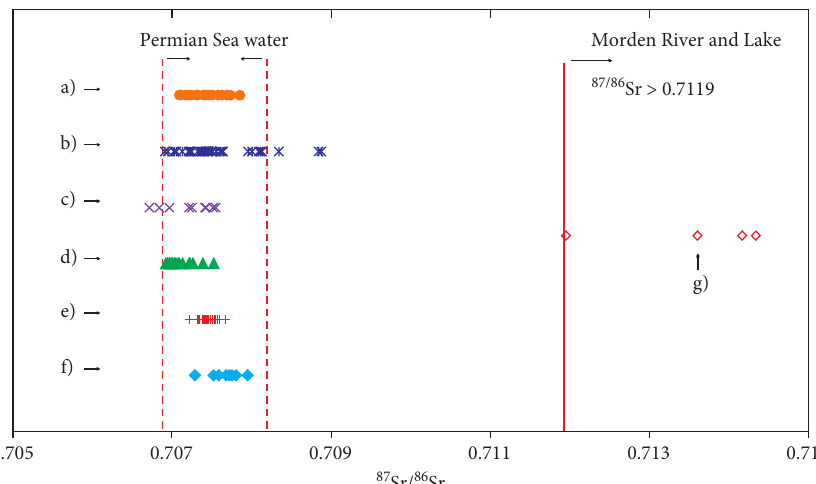
Figure 8: Sr isotopic compositions of the Linxi Formation limestone from the Linxi area Guandi profile in eastern Inner Mongolia and the comparison with the 87 Sr/ 86 Sr values of Permian in the other area: the Sr isotopic compositions of (a) conodonts during the Permian and the Triassic in Pakistan [12], (b) conodonts during the Permian and the Triassic in the United States [12], (c) marine carbonates rocks of Late Permian in Upper Yangtze region [11], (d) conodonts during the Permian and the Triassic in Abadeh, Iran [9, 10], (e) marine limestone of Permian in South China [8], (f) Permian Linxi Formation limestone from the Linxi area in eastern Inner Mongolia, and (g) the lacustrine limestone of Triassic from the Linxi area in eastern Inner Mongolia.